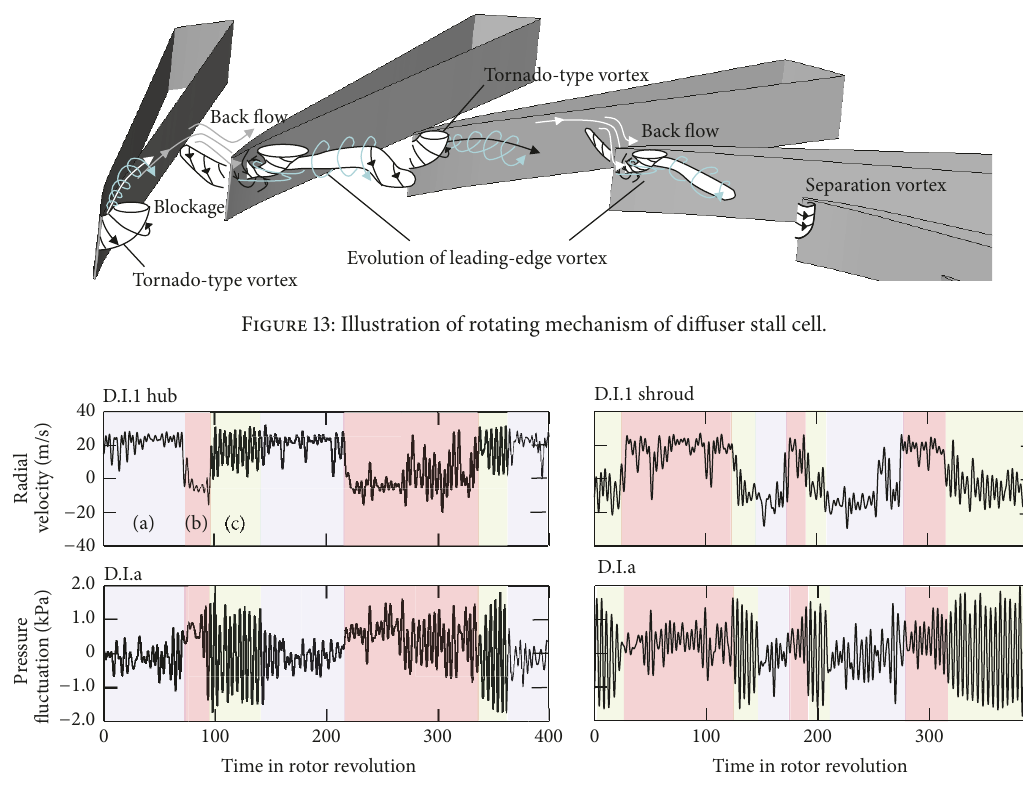
Figure 14: Radial velocity and pressure fluctuation traces at diffuser inlet ( 𝜙 = 0.10, 30Hz low-pass filter).